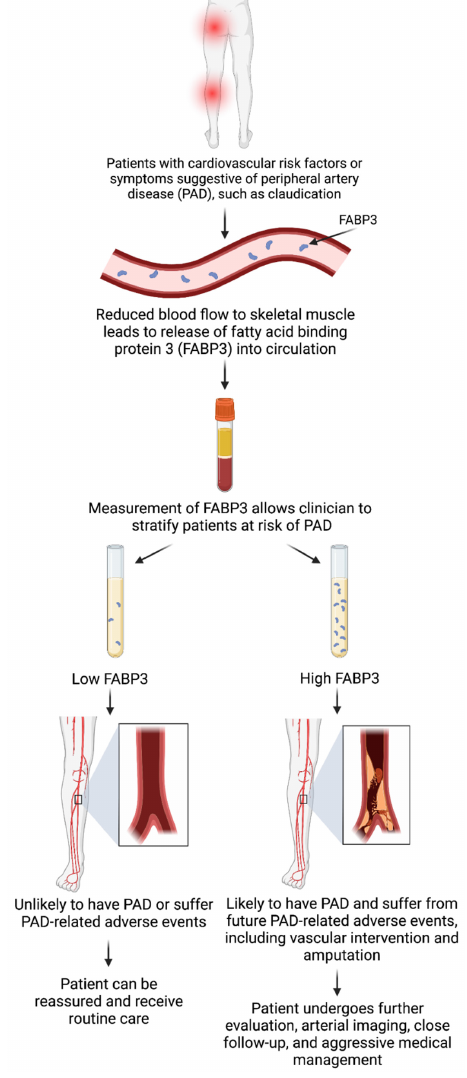
Figure 1. Clinical workflow for the use of fatty acid binding protein 3 (FABP3) as a diagnostic and prognostic biomarker for peripheral artery disease (PAD). Created using BioRender with permission.